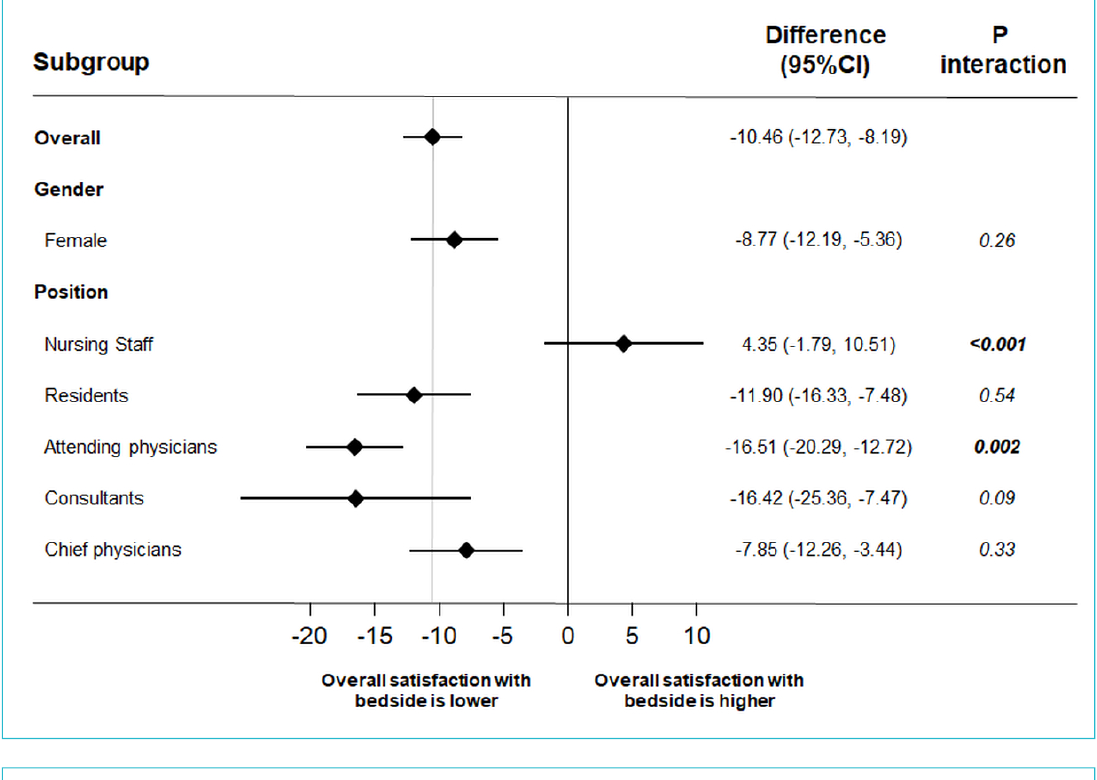
Figure 2: Healthcare workers mean preferences concerning different ward round related aspects. Means of preferences by profession mea- sured on a visual analogue scale (0 [bedside] to 100